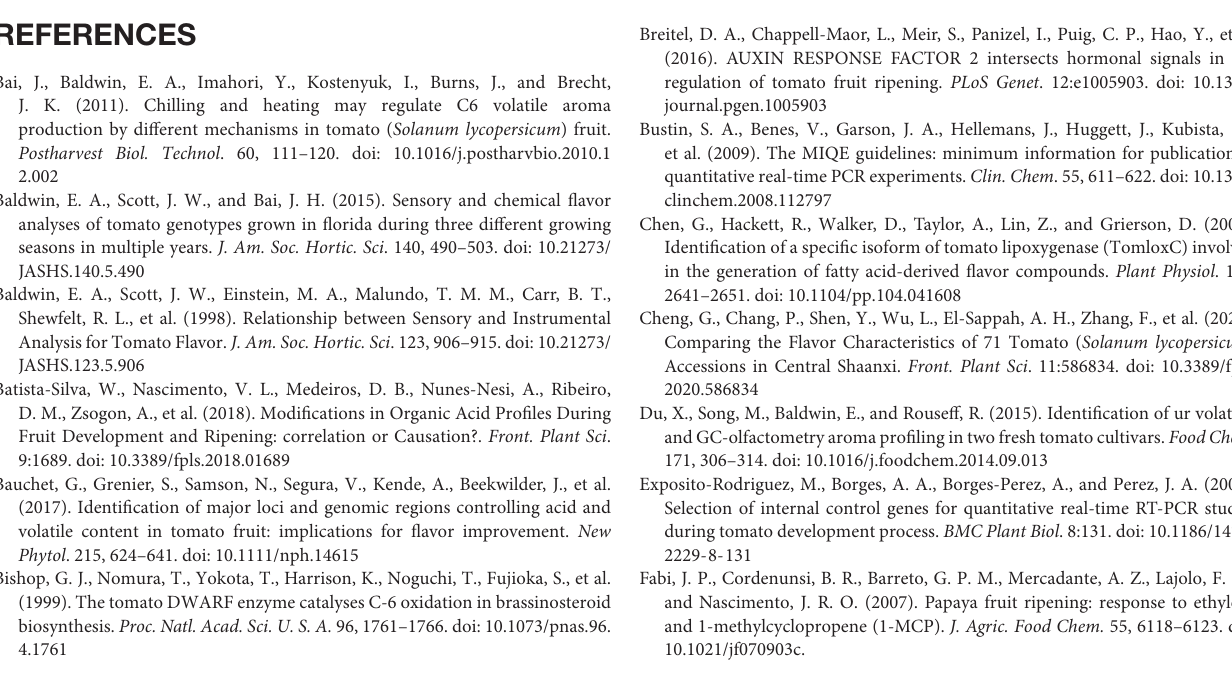
Supplementary Figure 2 | Variable importance in projection (VIP) score plot for the most important volatile organic compound (VOC) classes identified by the PLS-DA shown in Figure 4 . (A) VOCs identified in tomato ( S. lycopersicum L. cv. Micro-Tom) fruits after ethylene, auxin, and both treatments at 01, 04 (breaker), and 14 (red) days after harvest (DAH). (B) VOCs identified in tomato ( S. lycopersicum L. cv. Sweet Grape) fruits after ethylene, auxin, and both treatments at 01, 04 (breaker), and 08 DAH (red). Supplementary Figure 3 | Normalized area of volatile organic compounds important to tomato ( S. lycopersicum L. cv. Micro-Tom) fruits aroma after ethylene, auxin, and both treatments throughout ripening. CTRL, control group. ETHY, ethylene-treated group. IAA, indole-3-acetic acid-treated group. ETHY + IAA, group treated with both hormones. Each value is presented as the mean, and vertical bars represent the standard deviation of three replicates ( n = 3). Supplementary Figure 4 | Number and relative area of volatile organic compounds (VOCs) in tomato ( S. lycopersicum L. cv. Sweet Grape) fruits after ethylene, auxin, and both treatments at 0 (mature green), 04 (breaker), and 08 (red) days after harvest (DAH). (A) Number and relative area of VOCs according to the compound classes. (B) Number and relative area of VOCs obtained from the same precursors. CTRL, control group. ETHY, ethylene-treated group. IAA, indole-3-acetic acid-treated group. ETHY + IAA, group treated with both hormones. ( n = 3). Supplementary Table 1 | Primers used in the RT-PCR. Supplementary Table 2 | Identified volatile organic compounds in tomato ( Solanum lycopersicum L. cv. Micro-Tom) fruit after ethylene, auxin, and both treatments throughout ripening. Data presented are p -values for mean comparisons between treated and control fruits ( n = 3). Supplementary Table 3 | Identified volatile organic compounds in tomato ( S. lycopersicum L. cv. Sweet Grape) fruit after ethylene, auxin, and both treatments throughout ripening. Data presented are p -values for mean comparisons between treated and control fruits ( n = 3). Supplementary Table 4 | Identified volatile organic compounds in tomato ( S. lycopersicum L. cv. Micro-Tom) fruits after ethylene, auxin, and both treatments at breaker and red stages. Data presented are p values for mean comparisons between treated and control fruits ( n =